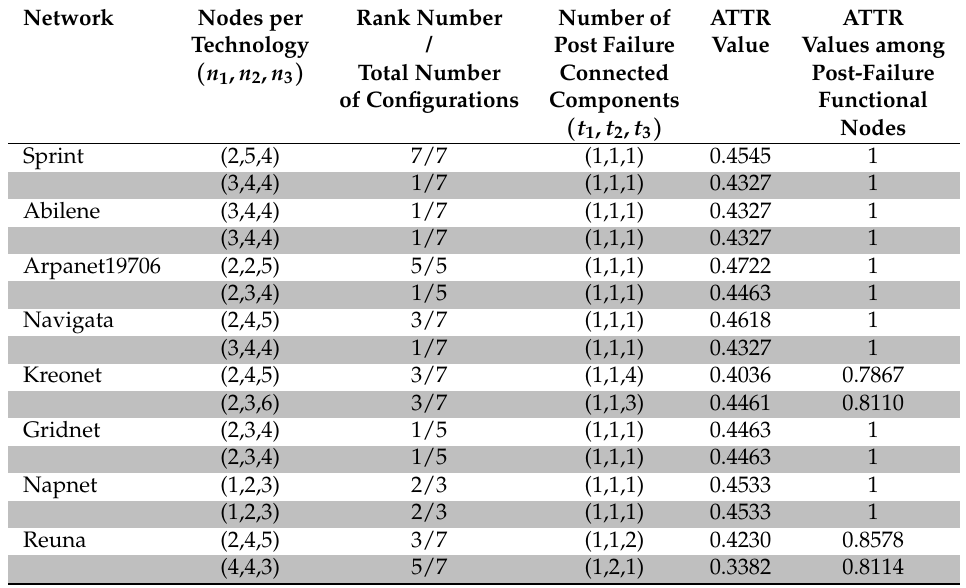
Figure 12. Relationship between the average degree of the network topologies and the average number of post-failure connected components from Table 1. Table 1. Results from the multiculture network design for the second and third optimization